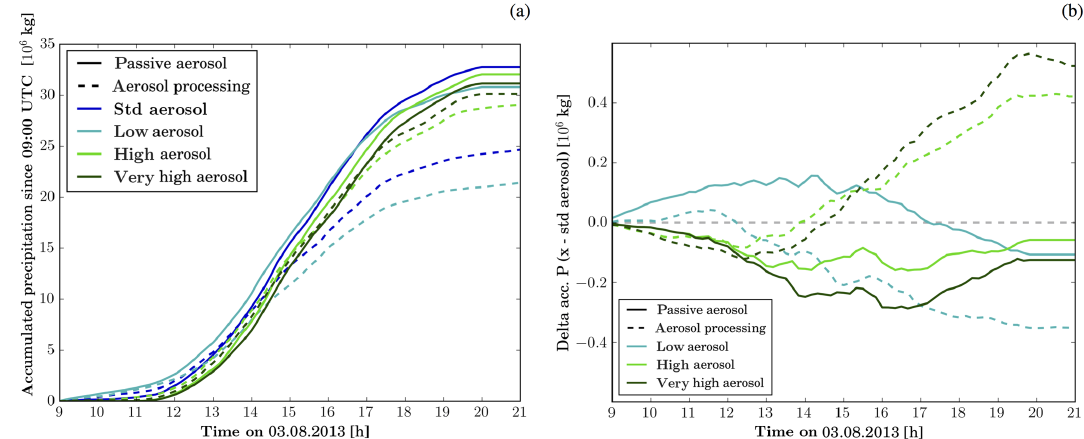
Figure 6. (a) Time evolution of accumulated precipitation since 09:00UTC. (b) Change in accumulated precipitation relative to simulations with the standard-aerosol scenario. Different line colours indicate the different aerosol initial conditions. Solid lines correspond to simulations with passive aerosols and dashed lines to simulations with aerosol processing.